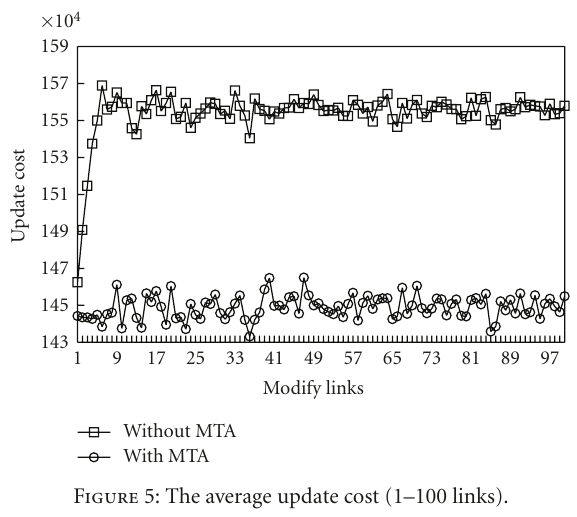
Figure 5: The average update cost (1–100 links).